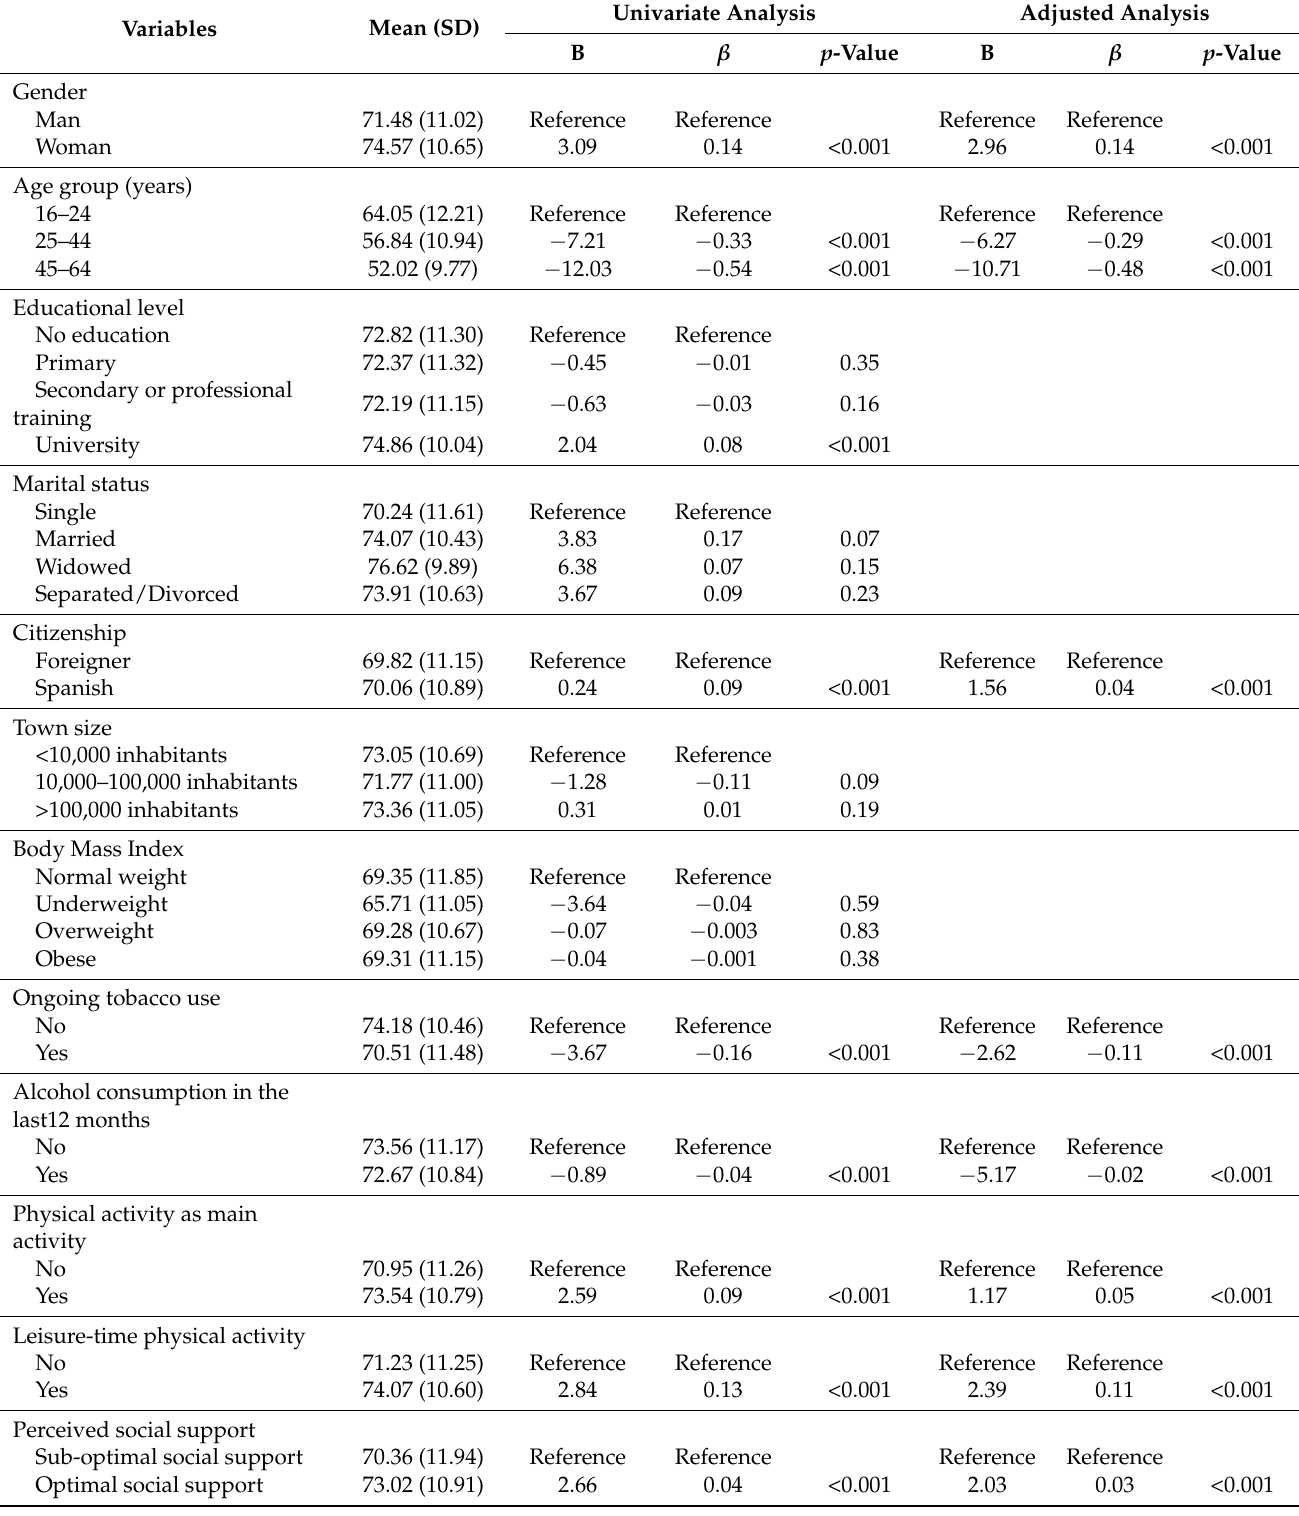
Table 2. Univariate and adjusted linear regression models predicting diet quality scores in workers aged 16–64 years ( n = 27,455)